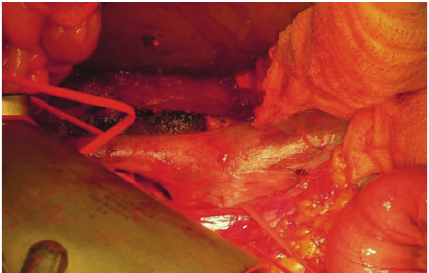
Figure 3: Intraoperative exposure of the tumor. The mass was firmly impinged to the bone and to the posterior aspect of the common iliac vein in its passage to extern iliac vein. In order not to damage the iliac veins and to save the hypogastric vein, the last lumbar vein was tied and the vena cava was raised and moved laterally.